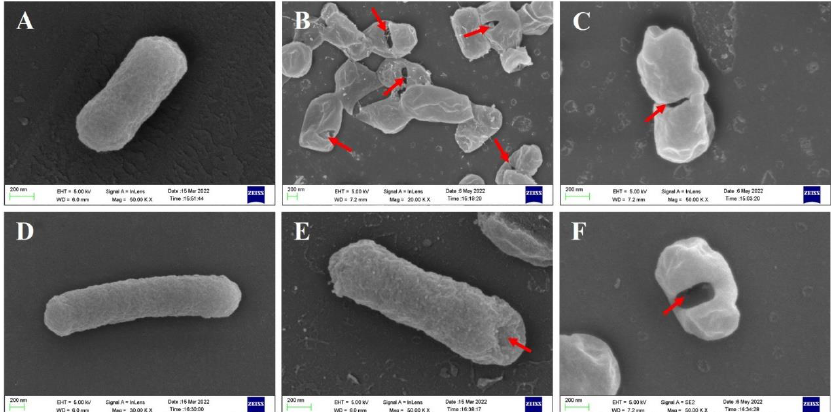
Figure 9. Morphological observation and cellular contents observation of EcN BGs and ST BGs by SEM. ( A ): Untreated control EcN cells; ( B , C ): EcN ghosts; ( D ) untreated control ST cells; ( E , F ): ST ghosts. The red arrows indicated the lysis transmembrane tunnels.